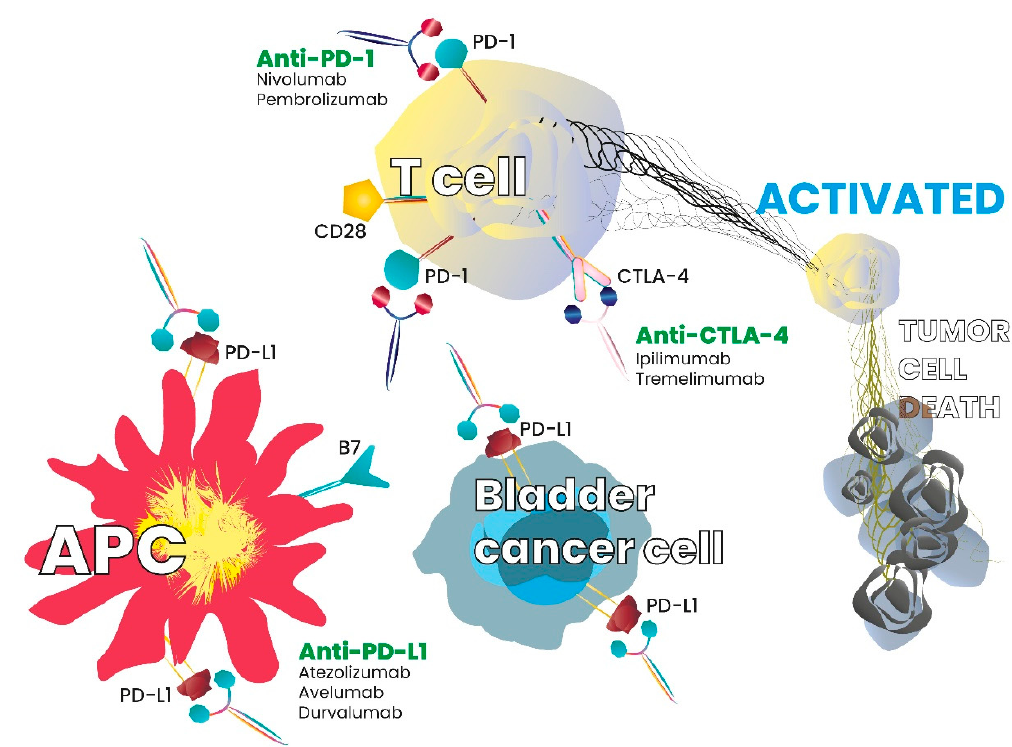
Figure 1. Checkpoint inhibitors and interaction with the immune system or tumor cells.